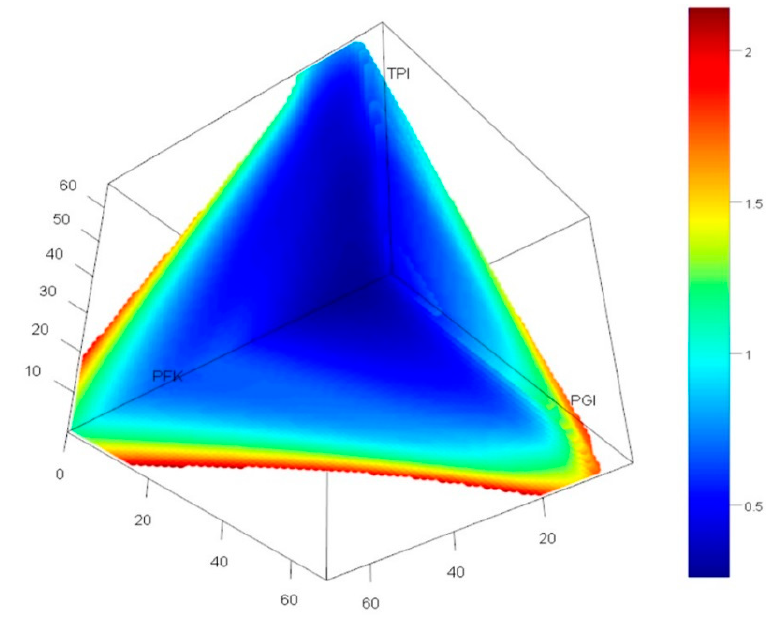
Figure 12. 3D-representation of cost estimated for all the enzyme concentrations generated. The color gradient is according to the cost required for each balance: blue is the lowest and red is the highest cost for a selected balance of the four enzymes PGI, PFK, FBA and TPI.